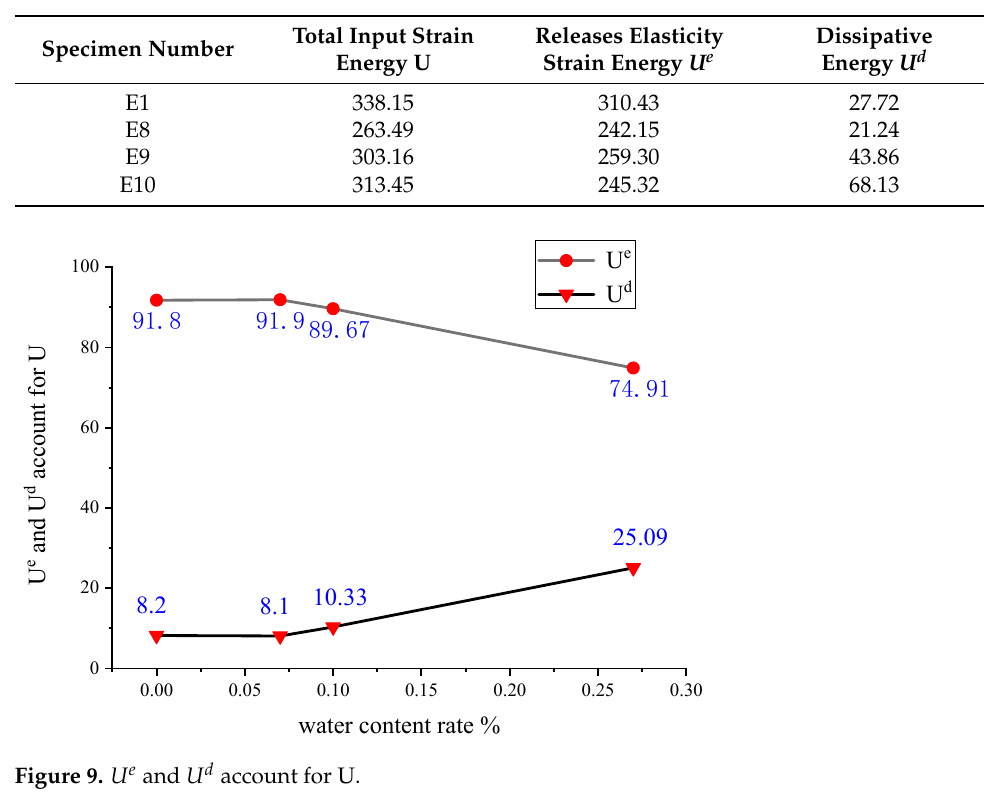
Table 7. The strain energy corresponding to the peak point of each specimen.